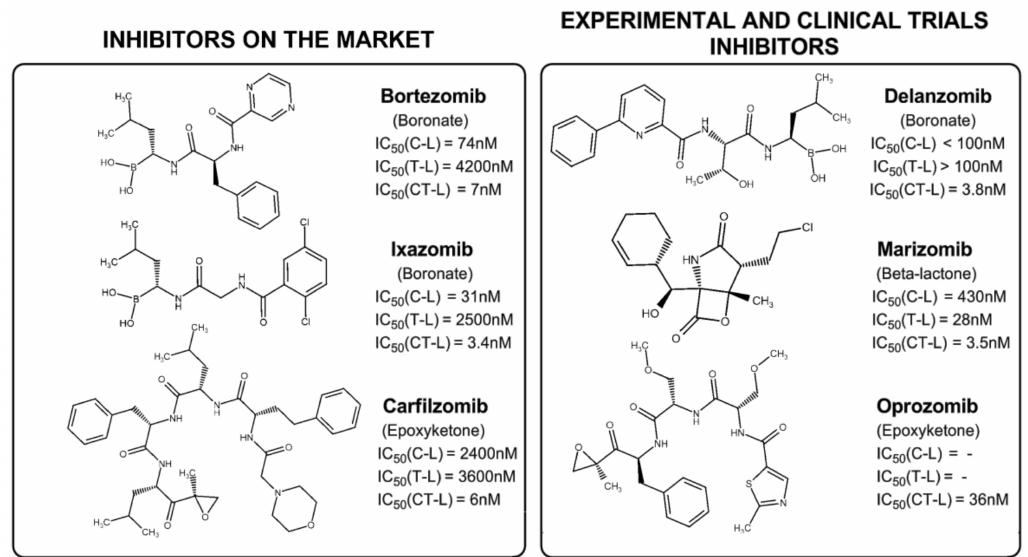
Figure 3. Clinical or pre-clinical Human 20S proteasome inhibitors. Note that, even though largely considered an experimental compound, marizomib has received approval as an orphan drug for glioblastoma. Additional details can be found in Table 1. C-L: Caspase-like active site; T-L: Trypsin-like active site; CT-L: Chymotrypsin-like active site. References for IC 50 values: Bortezomib and carfilzomib, Demo et al. [33]; ixazomib, Kupperman et al. [34]; carfilzomib, Demo et al. [33]; delanzomib, Piva et al. [35]; marizomib, Chauhan et al. [36]; oprozomib, Zhou et al. [37].